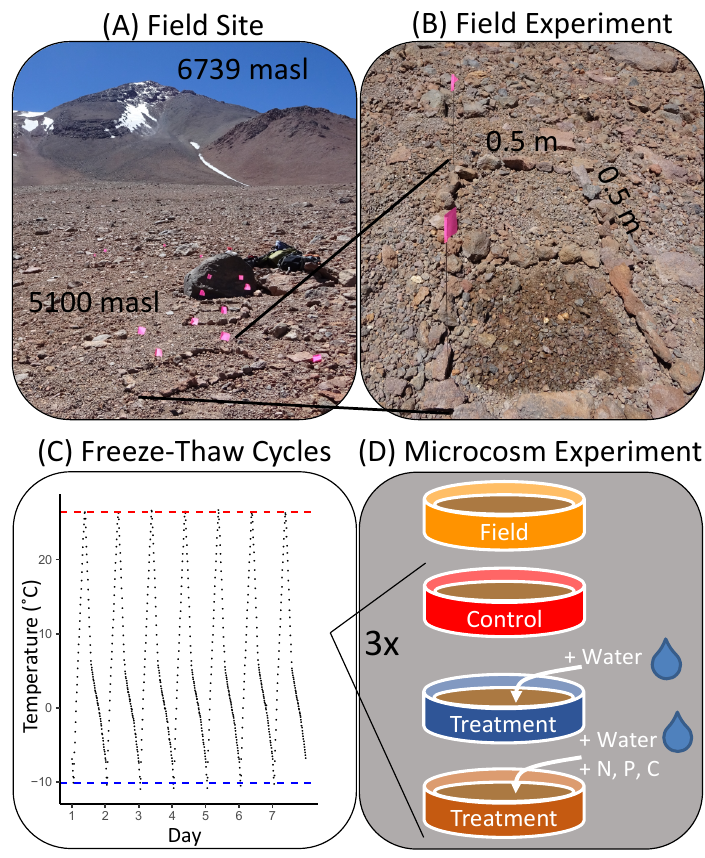
Figure 1. Study site and experimental design. ( A ) Location of soil sampling site at 5103 m.a.s.l. on Volcán Llullaillaco (24°44.043, 68°34.573). One of the false summits (~6400 meters above sea level (m.a.s.l).) of Volcán Llullaillaco is visible in the background. ( B ) Close-up view of one of the plots of the environmental manipulation experiment: the top plot has not been amended yet, while the bottom plot received water addition. ( C ) Temperature cycling as recorded in the environmental chamber over the course of the microcosm experiment. The red dashed line represents the mean daily maximum temperature of 26.42 °C. The blue dashed line represents the mean daily minimum temperature of −10.07 °C. ( D ) Treatments of the soil microcosm experiment: initial field soil and controls, water additions, and water and nutrient additions exposed to freeze–thaw cycles, each replicated four times.